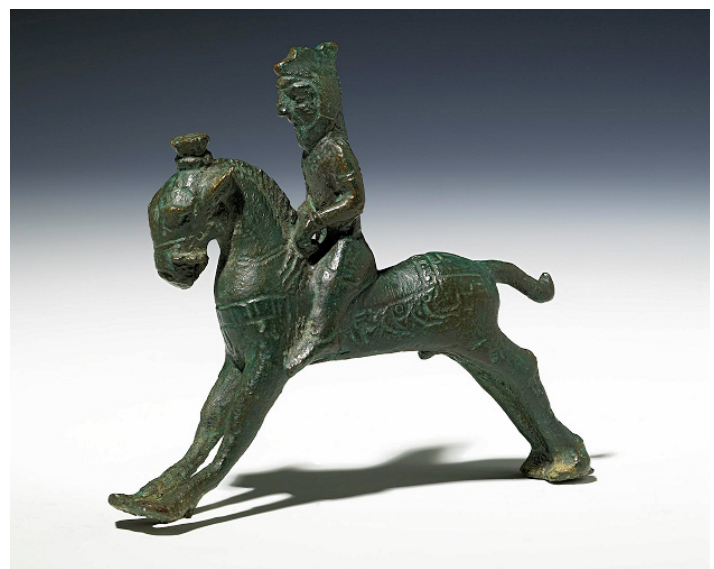
Figure 9. Mounted rider in Median dress (BM inv. no. 117760; reg. no. 1890,0308.5); statuette, bronze; found in Egypt (?); Achaemenid, ca. 5th–4th cent. BCE [image courtesy of the Trustees of the British Museum, London].